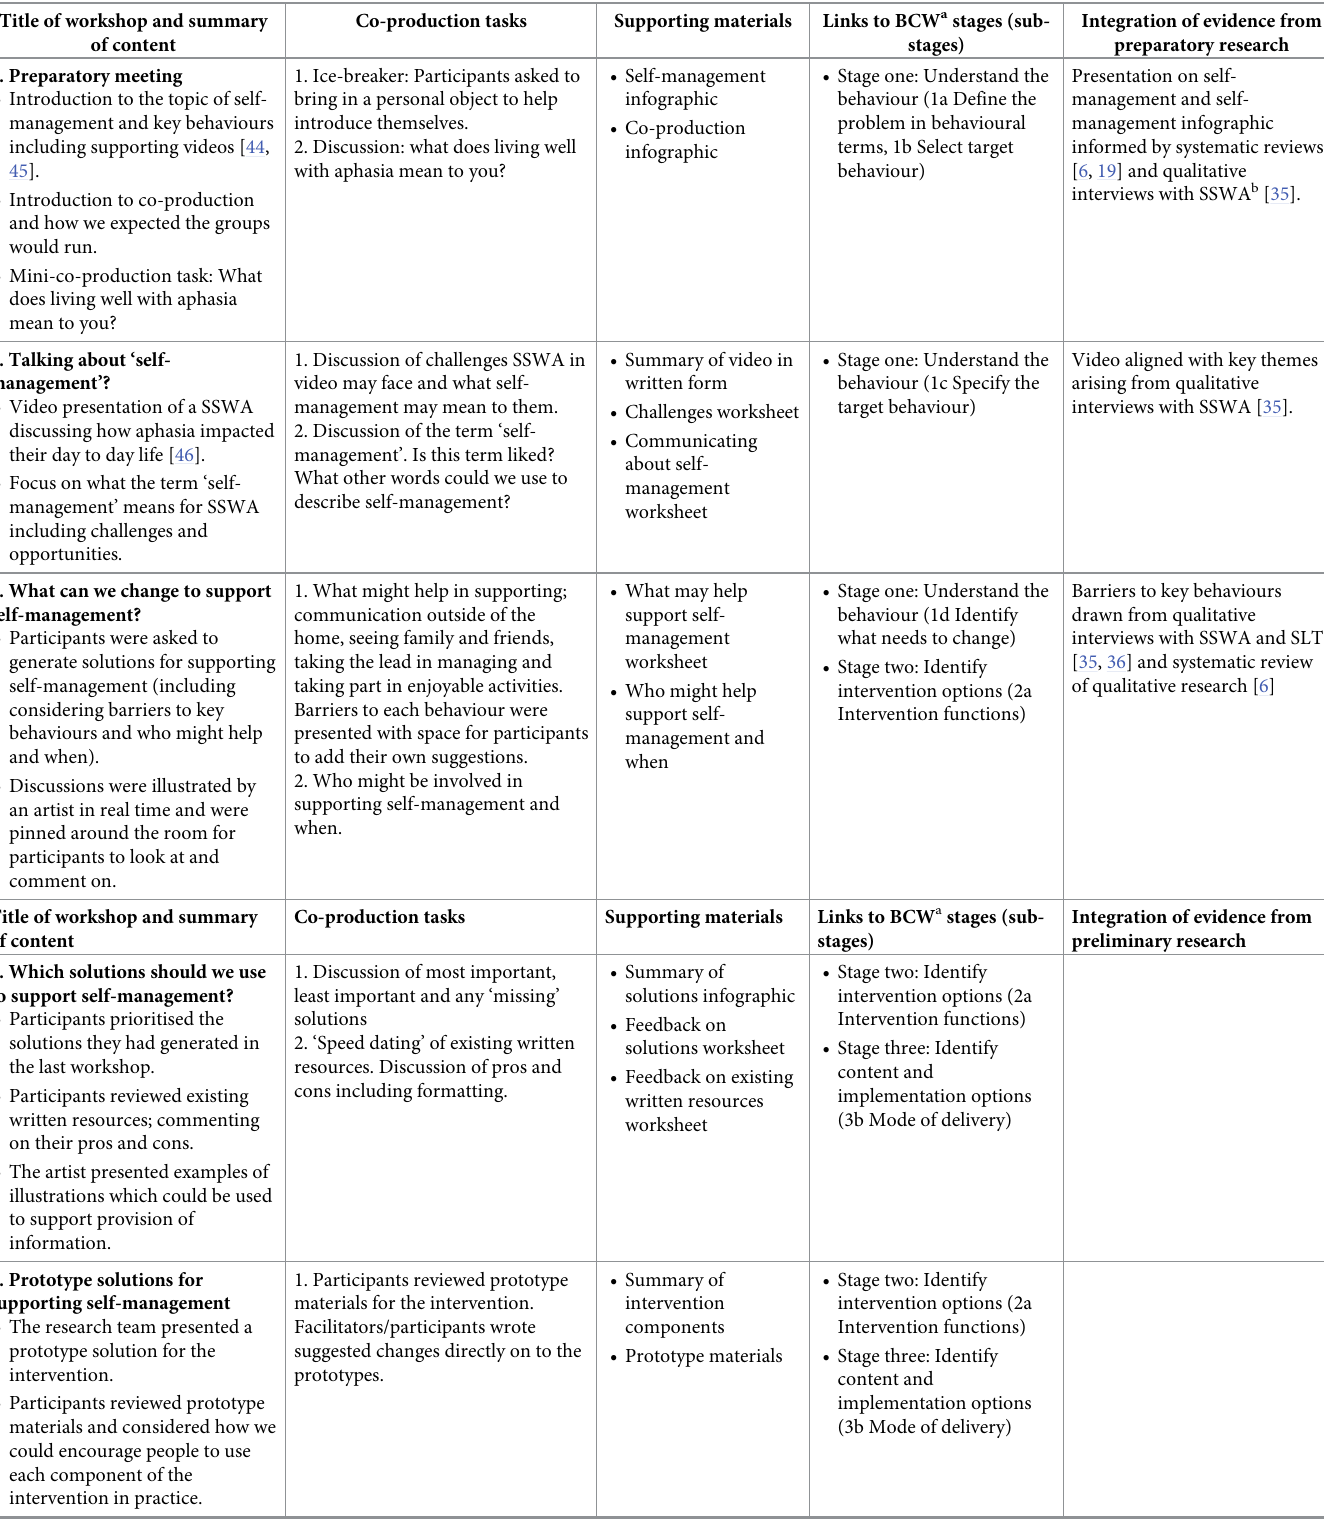
Table 1. Overview of workshop